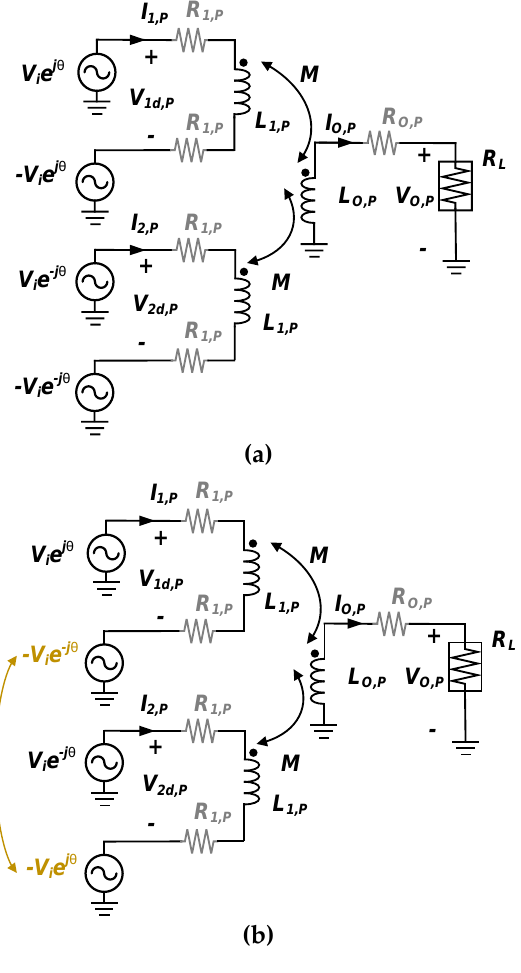
Figure 7. ( a ) A non-ideal PCT model with typical input feeding structure; ( b ) a non-ideal PCT model with the proposed input feeding structure.